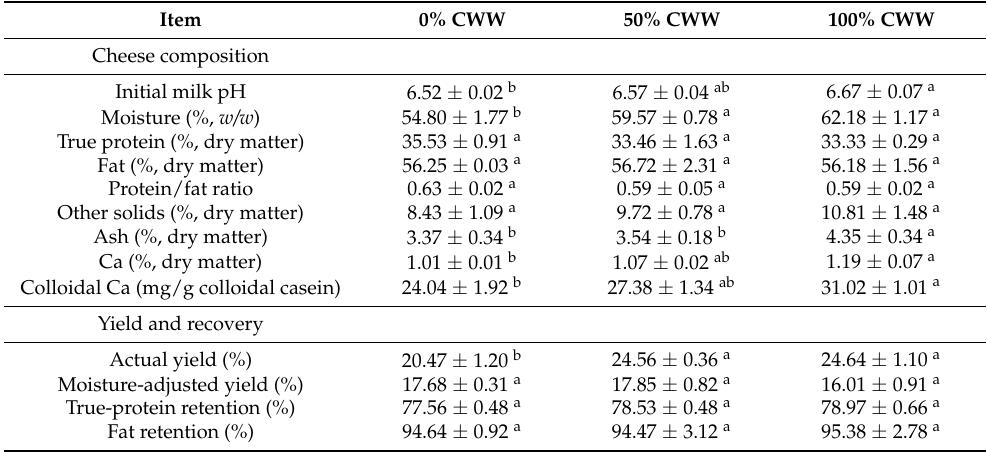
Table 4. Influence of concentrated-white-wastewater addition on model-cheese composition, yield and